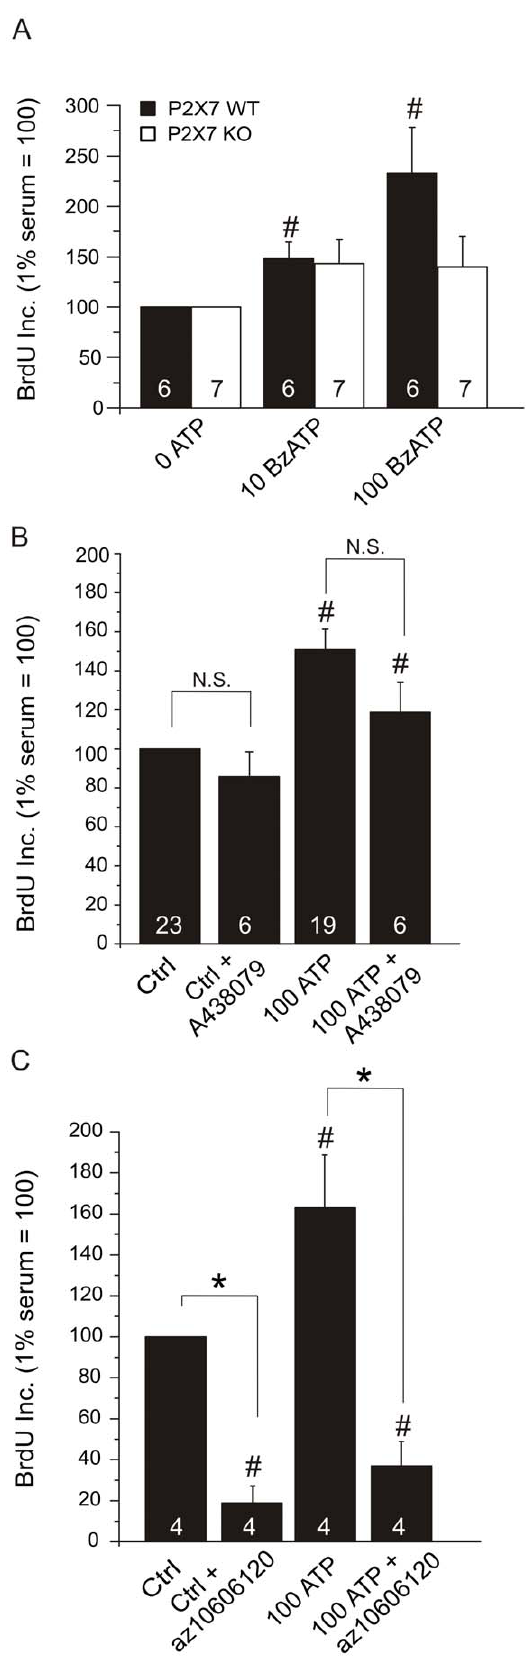
Figure 8. Effect of BzATP, A438079 and az10606120 on proliferation of PSC. A. The effect of BzATP on WT and KO PSCs (n=6–7). All results were normalized to 1% serum controls that were set to 100%. The effect of: B. the P2X7 receptor A438079 inhibitor (10 m M); C. and negative allosteric modulator az10606120 (10 m M) on the basal proliferation response and in WT PSCs stimulated state with 100 m M ATP (n=4–23). Significant difference (P , 0.05) from respective controls ( # ) and with/without the inhibitor (*) is